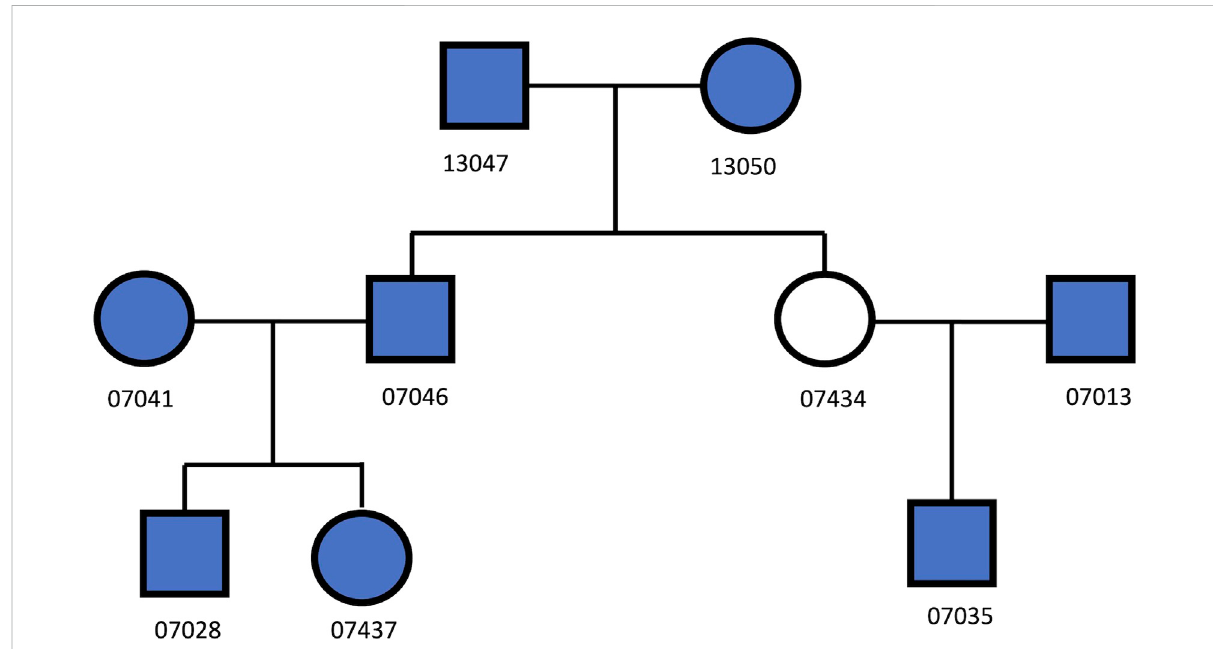
FIGURE 1 The relationships among the 8 UTAH/CEPH cell line samples ( fi lled in with blue